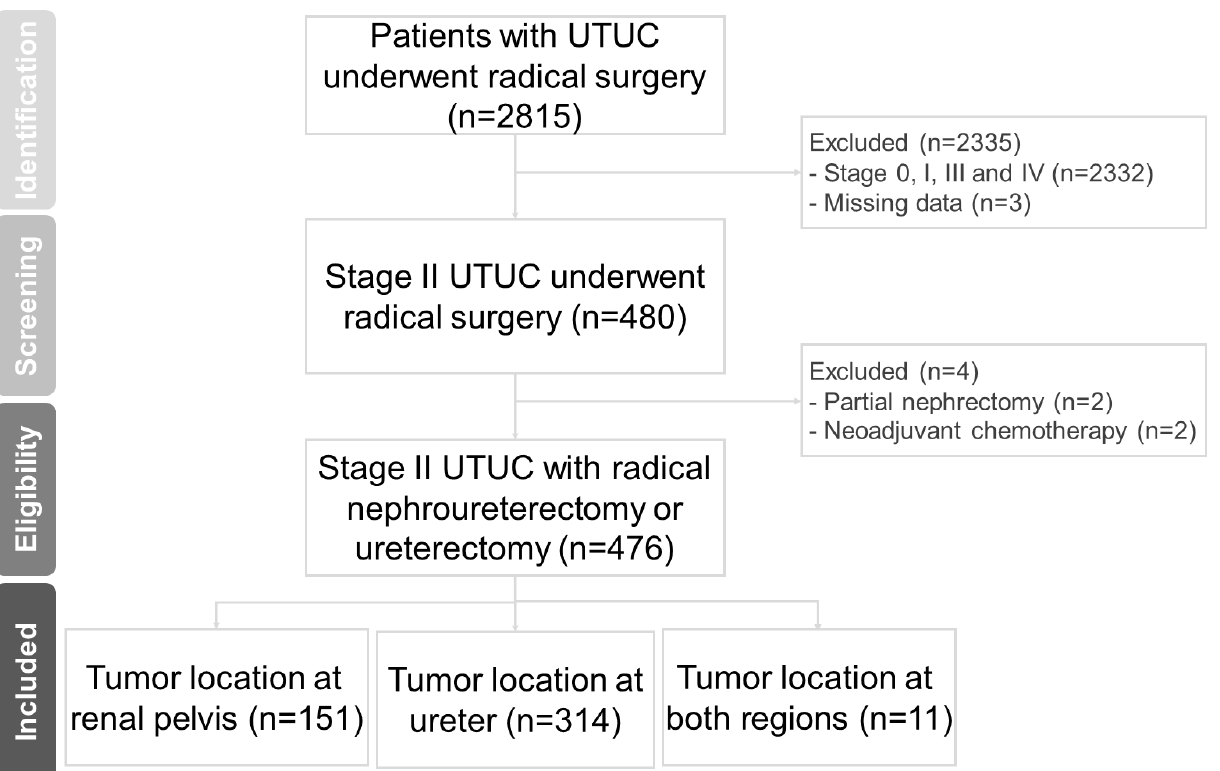
Figure 1. Flow chart for creation of the patient cohort dataset.